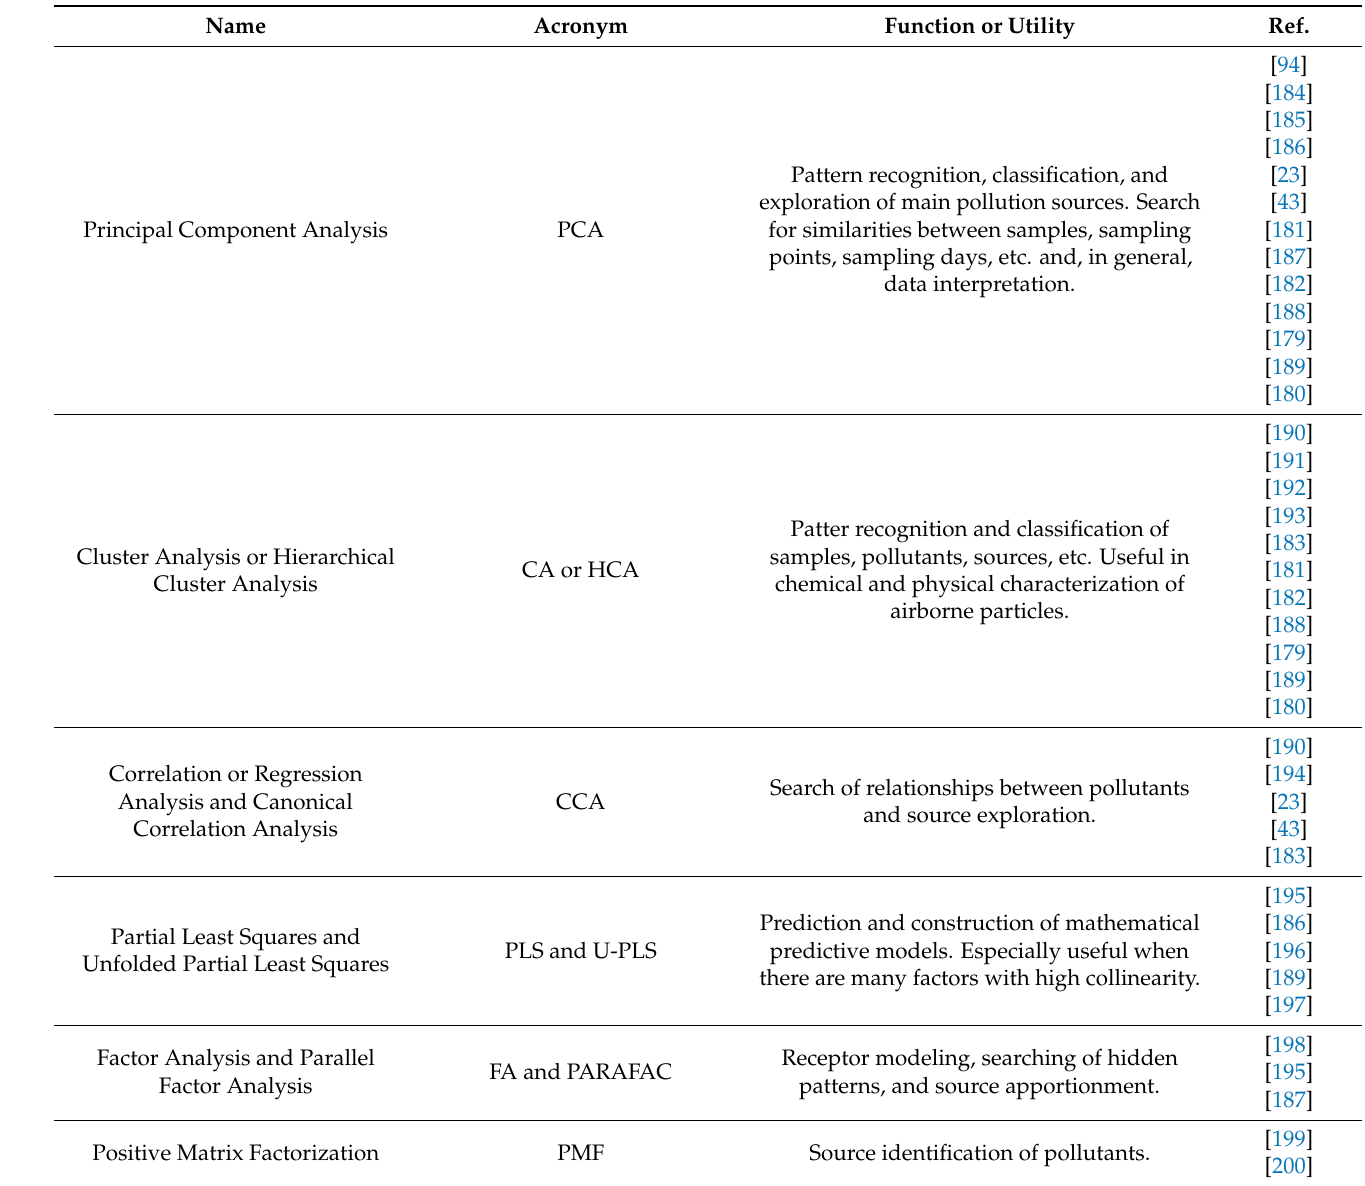
Table 5. Chemometric methods recently applied to atmospheric studies and aerosol